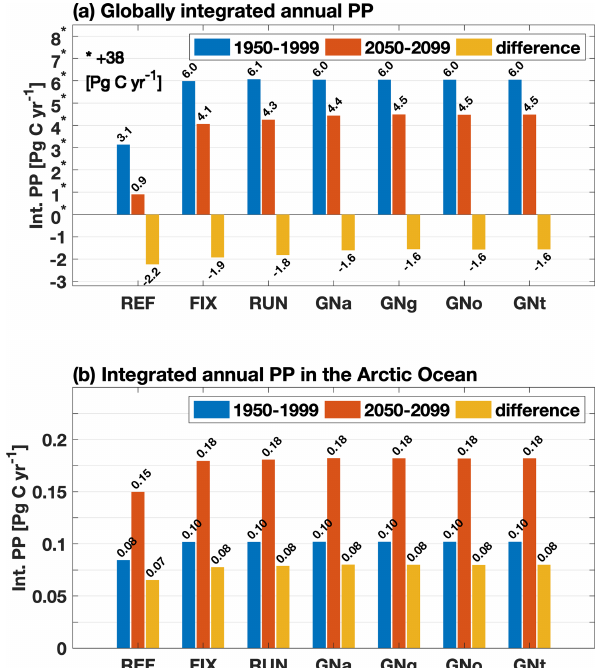
Figure 5. (a) Globally integrated annual mean primary production over 1950–1999 (blue) and over 2050–2099 (red) and the differ- ences between these two time periods (yellow) for all experiments; note that the positive numbers on the y axis (marked with stars) are scaled by minus 38PgCyr − 1 so that the negative numbers are visi- ble; (b) same as (a) but for the Arctic Ocean (ocean area north of the Bering Strait on the Pacific side and north of 70 ◦ N on the Atlantic side) for the same time periods as in (a) .